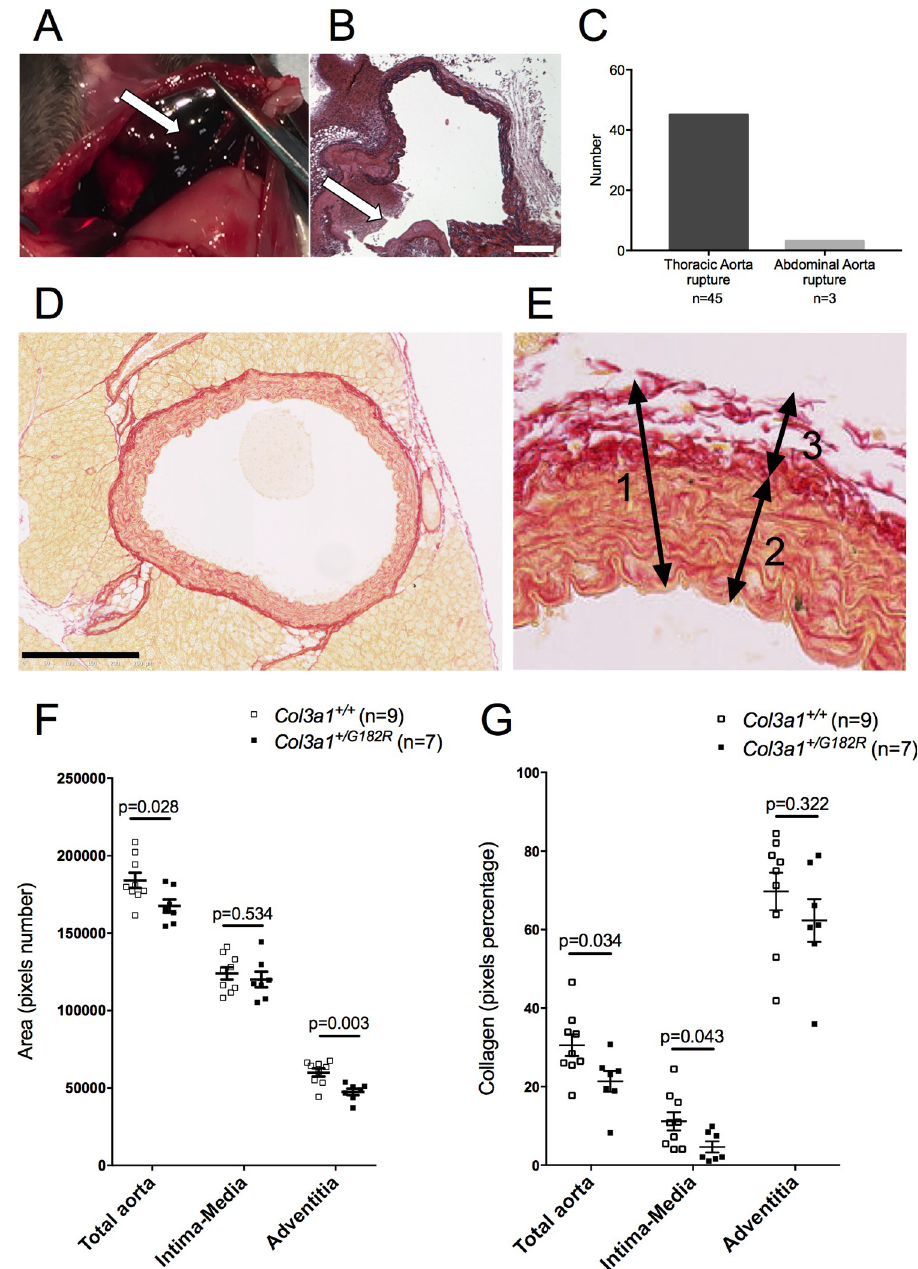
Fig 2. Assessment of collagen content in Col3a1 +/G182R untreated mice (Picrosirius red staining). A Hemothorax in Col3a1 +/G182R mice, white arrow shows the massive hemorrhage in the chest. B Histological staining (Hematoxylin) of the descending thoracic aorta of Col3a1 +/G182R dead mice. White arrow shows the spontaneous aortic rupture and hemorrhage. Scale bar = 50 μ m. C Localization of the aortic dissection/rupture determined through dissection in Col3a1 G182R/+ mice. D Histological staining (Picrosirius Red) of a descending thoracic aortic section in Col3a1 +/G182R mice. Scale bar = 250 μ m. E details of a descending thoracic aortic section to show the two considered layers in the aortic wall (1): the intima-media (2) and the adventitia (3). The area and the collagen density in the adventitia were calculated by subtracting the intima-media pixels from the total aorta pixels. F The graph represents the area of the total aorta, the intima-media and the adventitia in Col3a1 +/+ (n = 9) and Col3a1 +/G182R (n = 7) untreated male mice. The area of descending thoracic aorta and corresponding adventitia are lower in Col3a1 +/G182R mice compared to Col3a1 +/+ mice (Student-t test, p < 0.05). G The graph represents the collagen density in the total aorta, the intima- media and the adventitia in Col3a1 +/+ (n = 9) and Col3a1 +/G182R (n = 7) untreated male mice. The collagen density in the total aorta and the intima-media are lower in Col3a1 +/G182R mice compared to Col3a1 +/+ mice (Student-t test, p < 0.05) whereas it remains constant in the adventitia (Student-t test, p > 0.05). Data are expressed as the mean ± SEM.